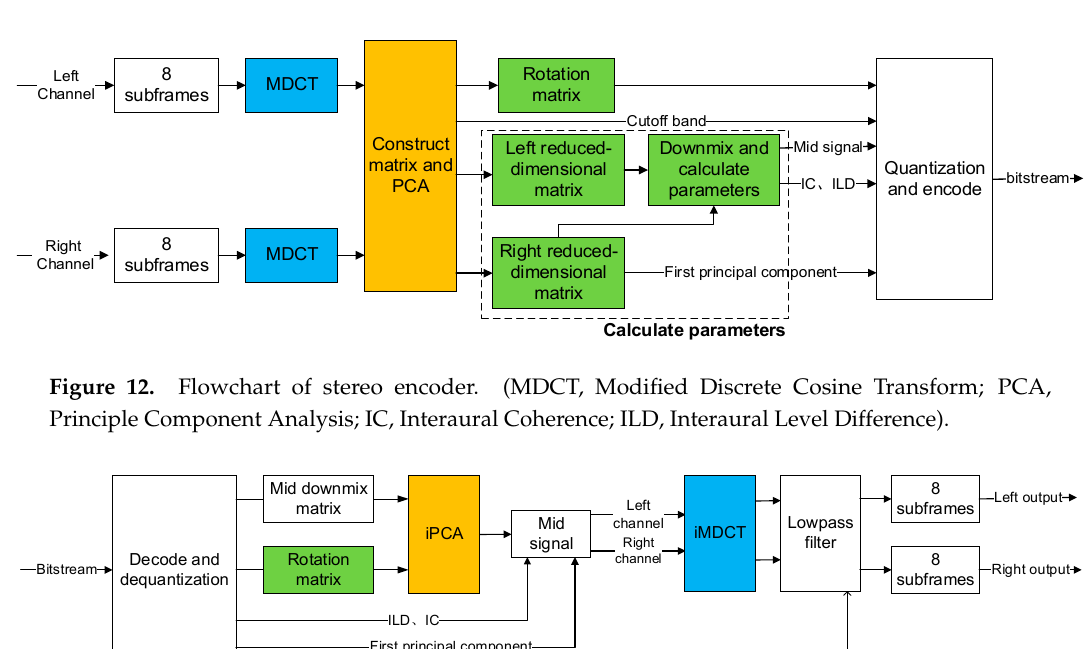
Figure 14. Subjective MOS of high-relation stereo signal. (MOS, Mean Opinion Score). 1